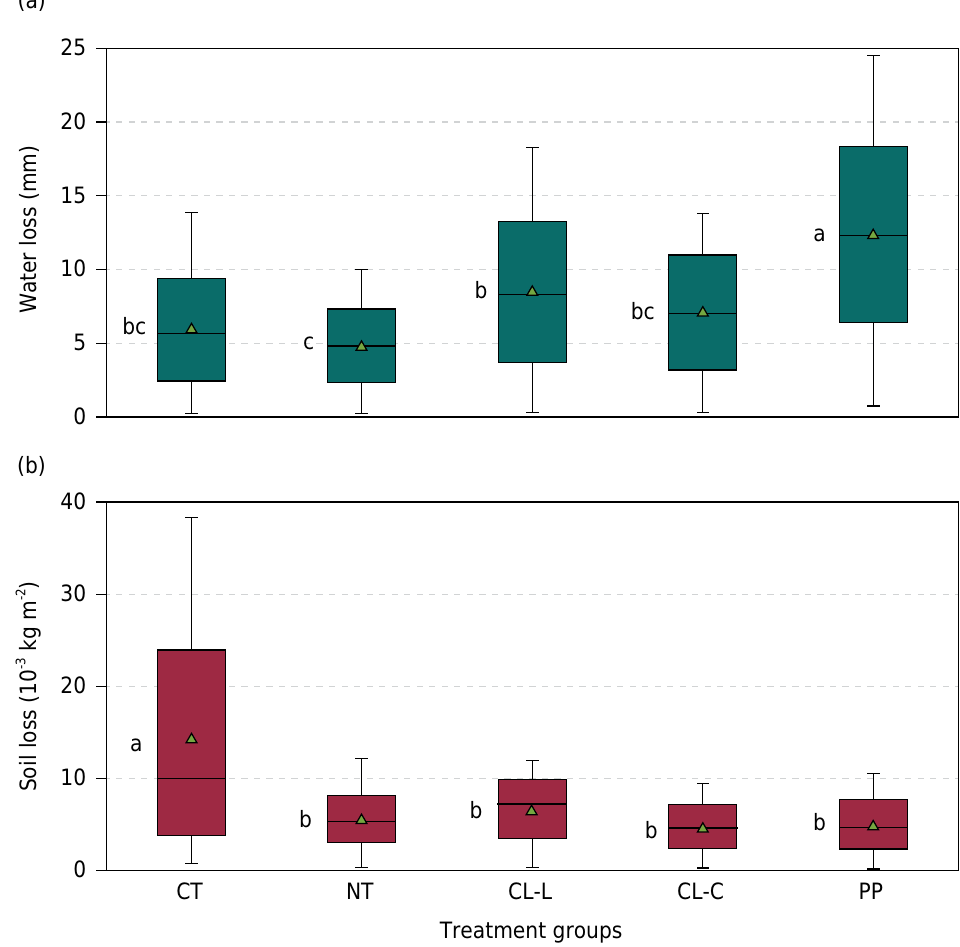
Figure 2. Boxplots of (a) water loss (mm) and (b) soil loss during the rainfall simulations on the agricultural land uses: soybean cropping under conventional tillage (CT), soybean cropping under no-till (NT), crop-livestock integration in the livestock phase (CL-L), crop-livestock integration in the cropping phase (CL-C), and Brachiaria decumbens permanent pasture under rotational grazing (PP). The 25th and 75th percentiles, the median with a line, and the mean with a triangle are shown; whiskers indicate the maximum and minimum values. Difference letters indicate different statistical groups by the Tukey test (α=